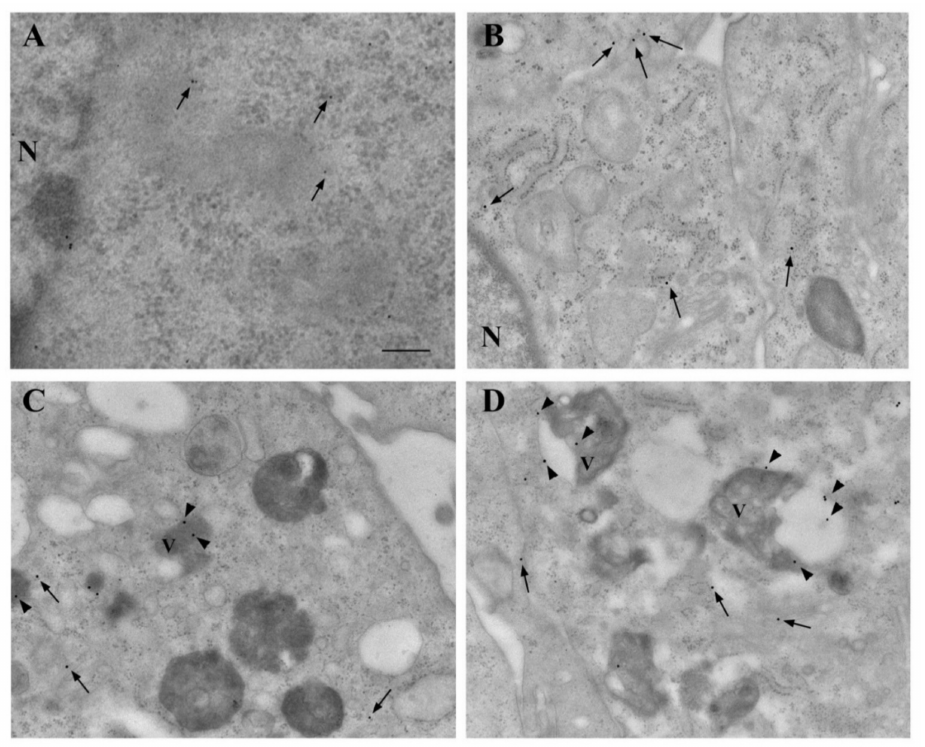
Figure 12. Rapamycin-induced α -syn vacuolar compartmentalization in U87MG cells. Representative micrographs showing astrocytes ( A ) and U87MG cells ( B ), in baseline conditions and following rapamycin exposure at 10 nM ( C ) and 100 nM ( D ). In astrocytes, α -syn was rarely found within the cytosol, nucleus, and vacuoles, whereas, in U87MG cells, α -syn immuno-gold was abundantly present in the cytosol and nucleus, with negligible vacuolar compartmentalization. Rapamycin reduced α -syn in the cell and increased its placement within the vacuoles. Arrows = α -syn immuno-gold particles in the cytosol; arrowheads = α -syn immuno-gold particles within the vacuoles. N = nucleus; V = vacuole. Scale bar = 0.28 µ